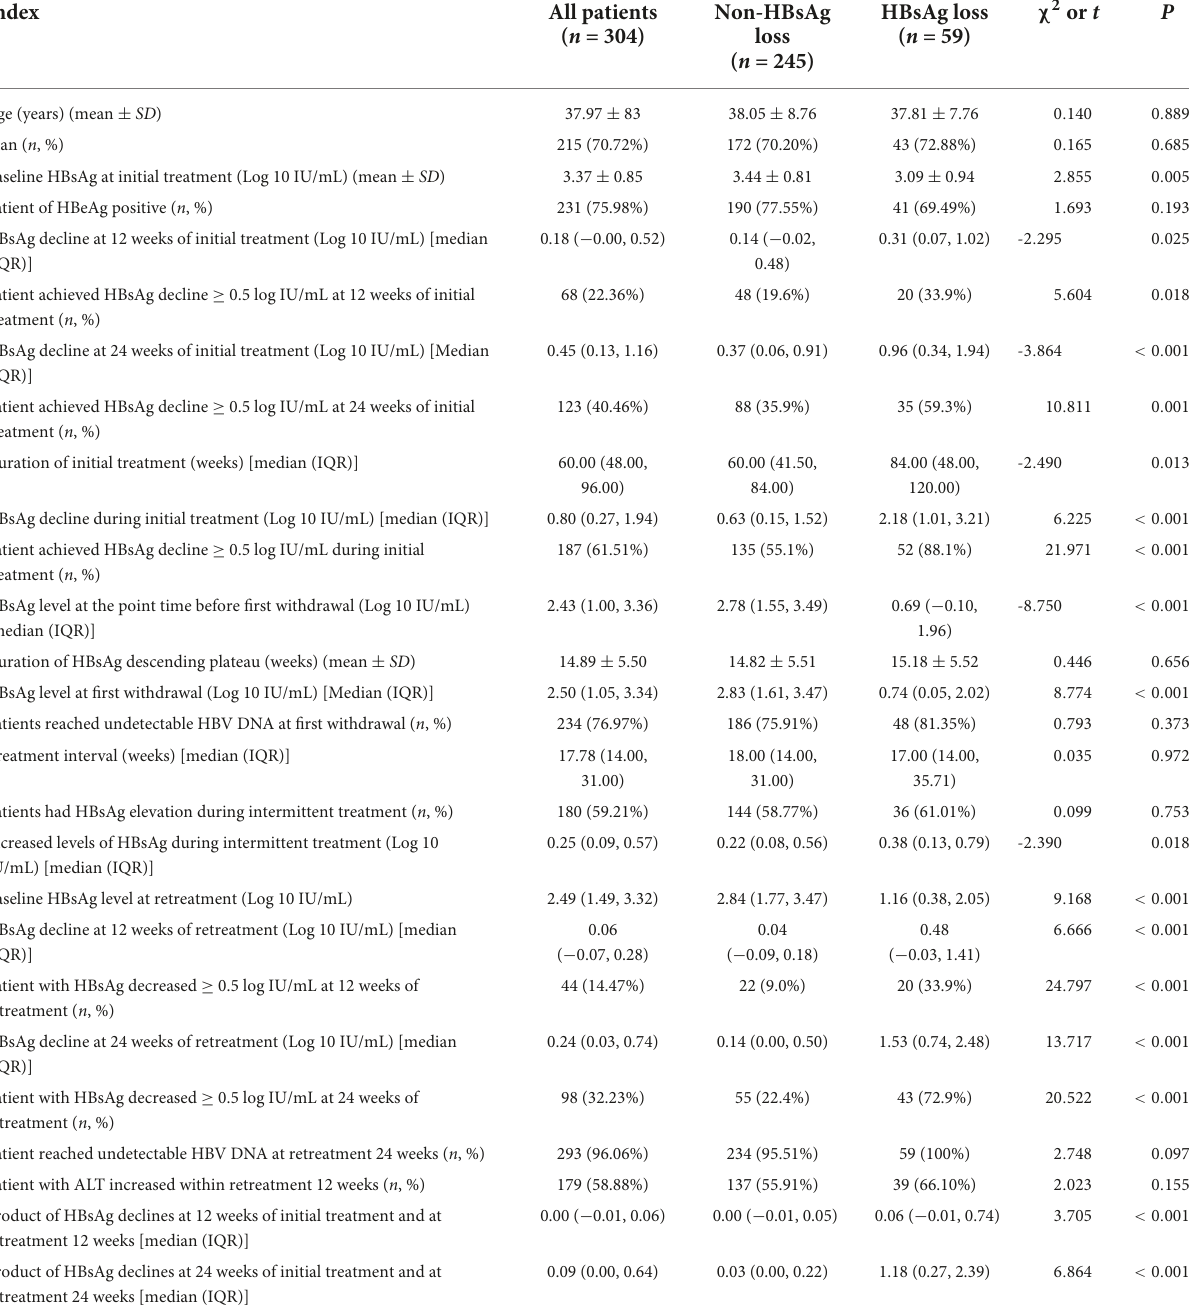
TABLE 1 Comparison of characteristics of patients with HBsAg loss and non-HBsAg loss after interferon